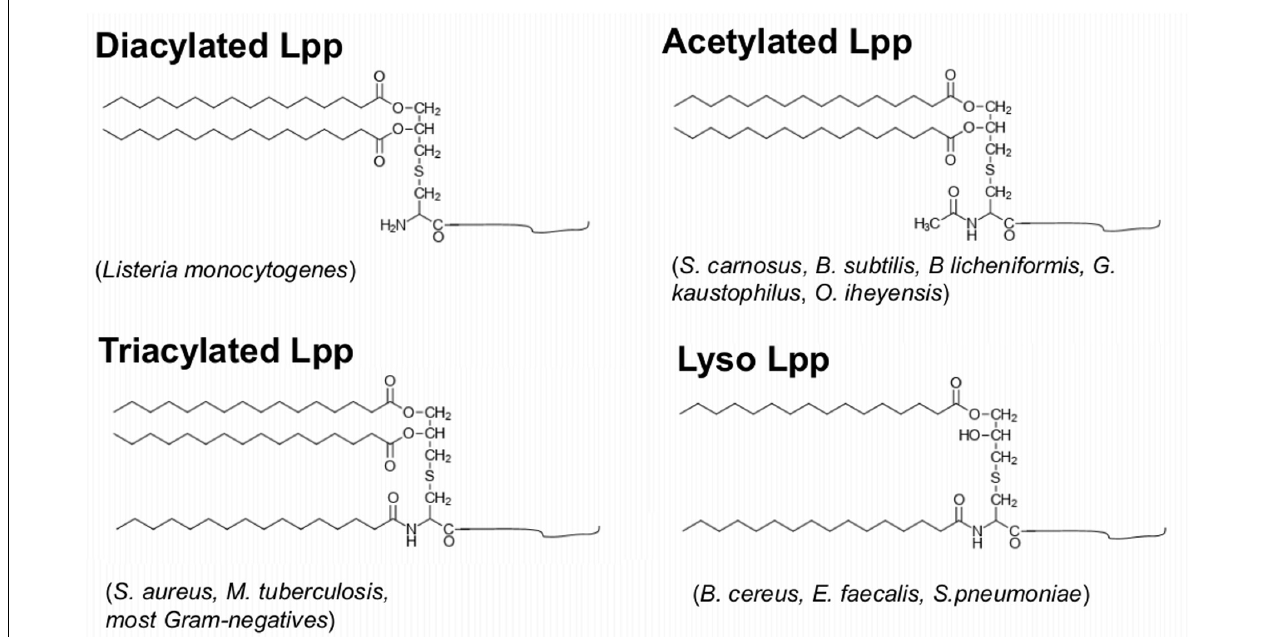
FIGURE 3 | Variation of the Lpp’s lipid structures in Gram+ bacteria. Diacylated Lpp contain a modified S-diacyl-glyceryl cysteine which is found for example in Listeria monocytogenes ; triacylated Lpp contain a modified N-acyl-S-diacyl-glyceryl cysteine which were found in S. aureus , M. tuberculosis , and most Gram-negatives; N-acetylated Lpp contain N-acetyl-S-diacyl-glyceryl cysteine which were found in S. carnosus , B. subtilis , B. licheniformis , G. kaustophilus , O. iheyensis ; Lyso Lpp contain a modified N-acyl-S-monoacyl cysteine which were found in B. cereus , E. faecalis , or S. pneumoniae .